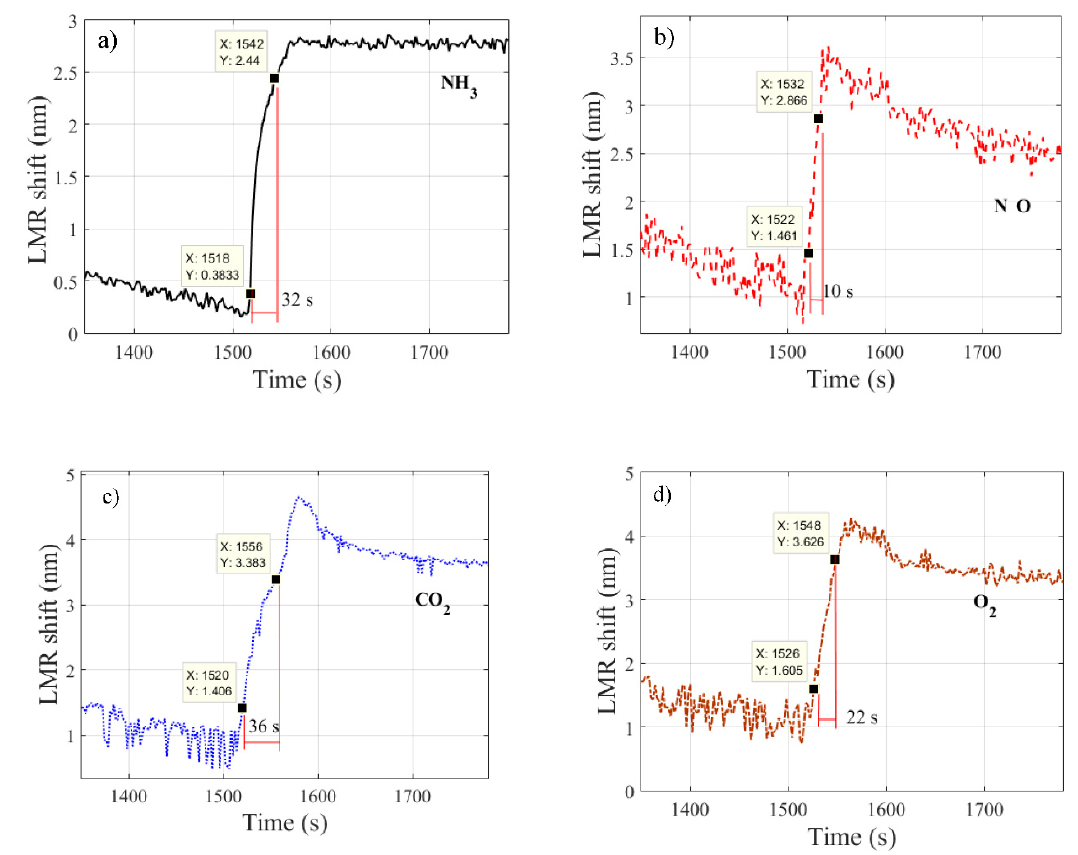
Figure 3. Time response of the LMR optical sensor during the third gas under test cycle: ( a ) NH 3 , ( b ) NO, ( c ) CO 2 and ( d ) O 2